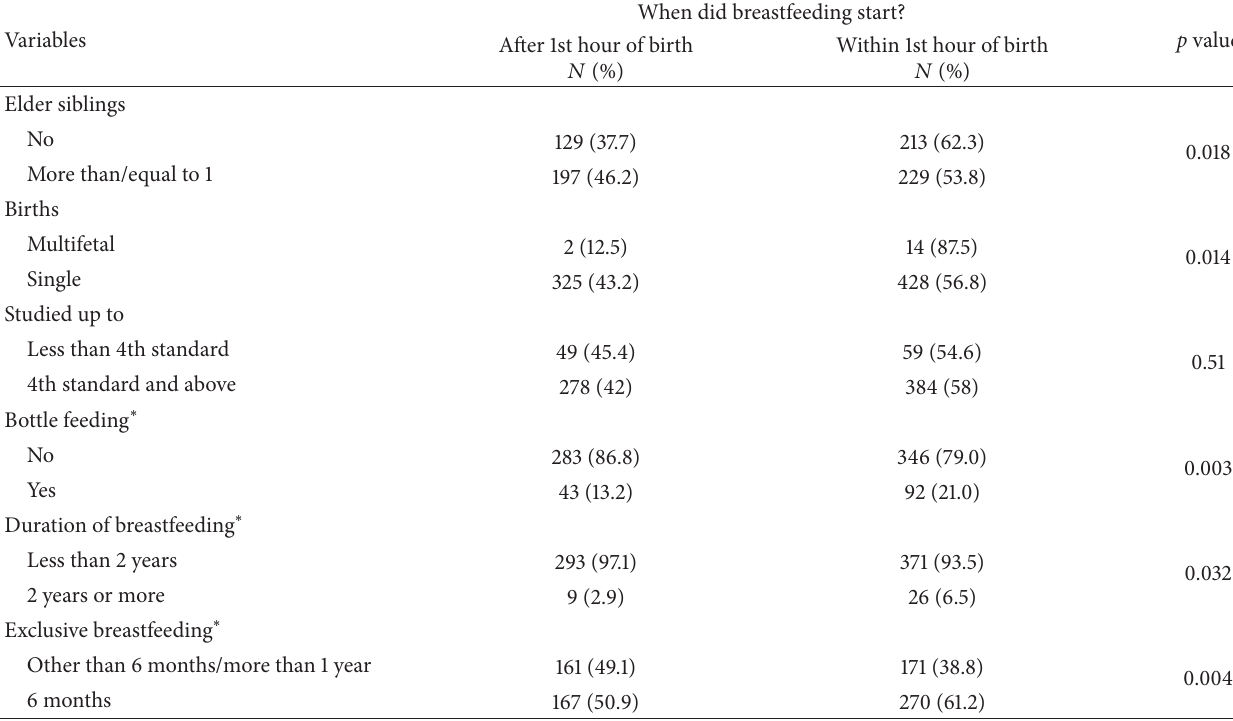
Table 2: Univariate analysis for time of starting breastfeeding after birth in children more than 2